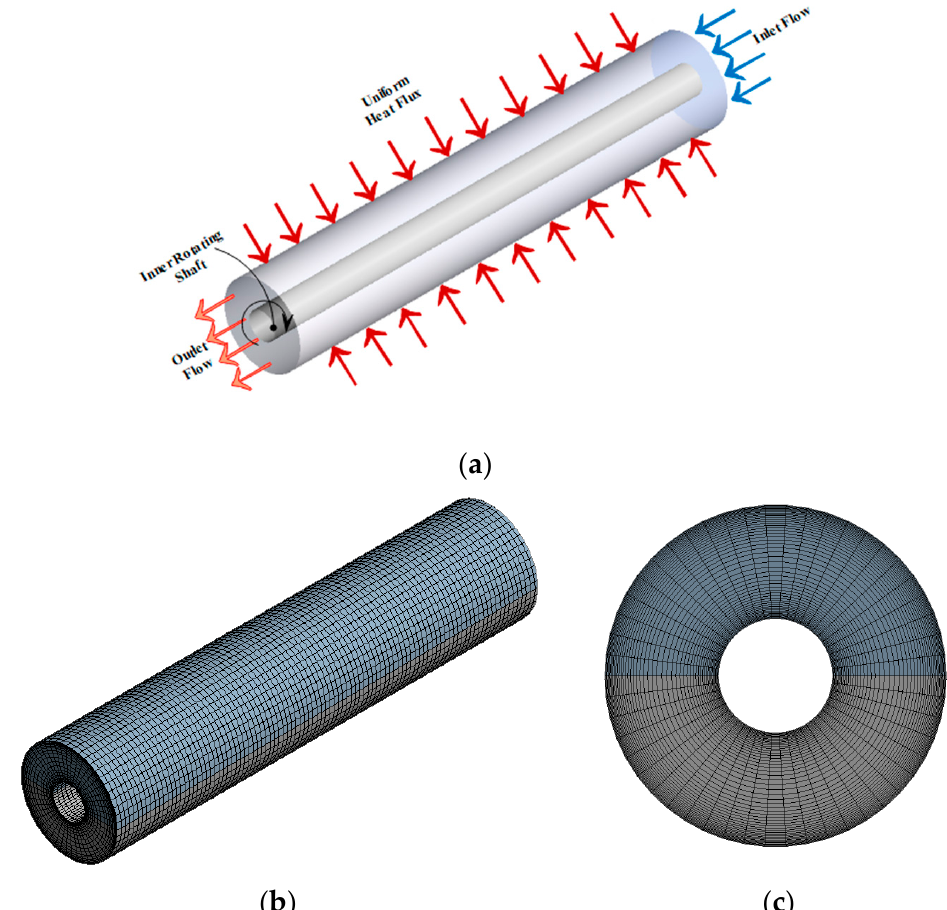
Figure 1. ( a ) Geometric model for the annular heat exchanger; ( b , c ) Computational meshing domain for 3D and front view of the model.